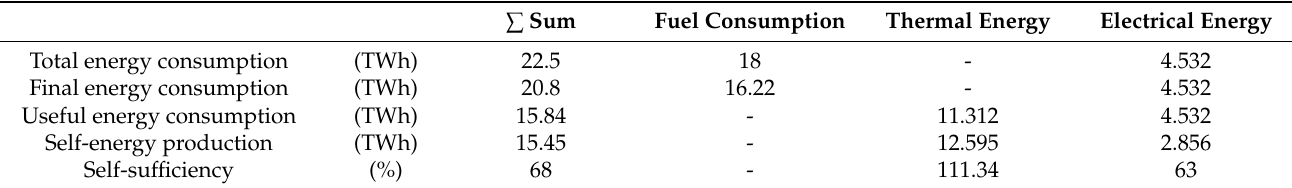
Table 4. Energy consumption and production in the Austrian Pulp and Paper sector in the year 2017 [5,9,28,29]